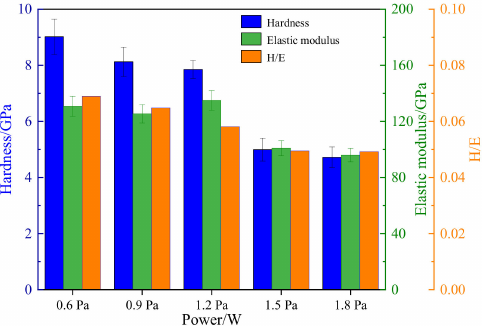
Figure 5. Hardness, elastic modulus and H/E of the composite coatings deposited at different deposition